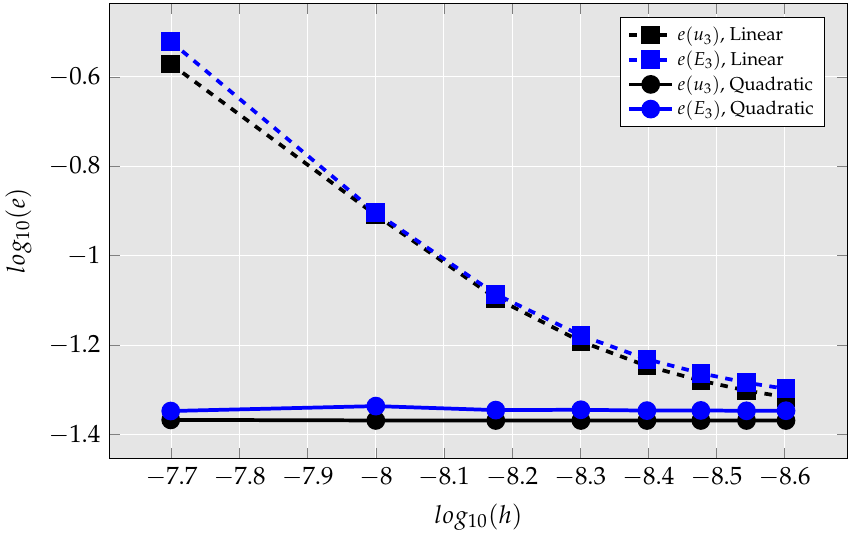
Figure 12. Relative errors and convergence rates of displacement u 3 and electric field E 3 for the developed linear and quadratic element with neglected strain gradient